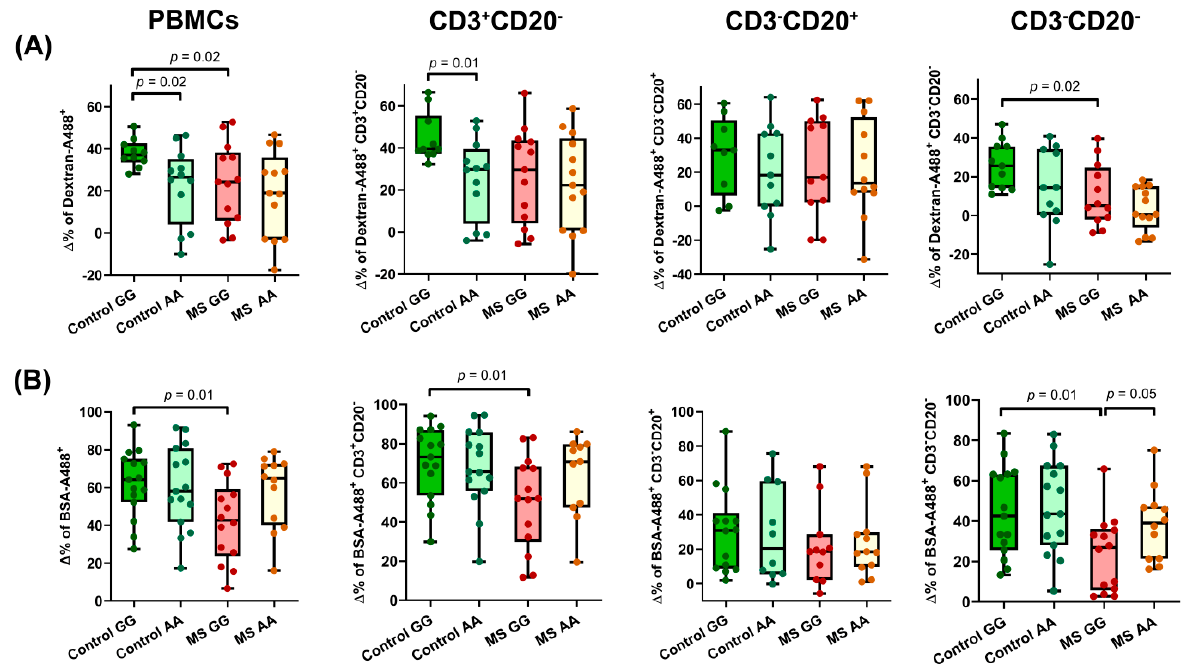
Figure 2. Effect of rs7665090 genotypes on endocytosisin PBMCs from healthy donors and MS patients pre-stimulated for 24 h or not with PHA. ( A ) Endocytosis of A488-Dextran 10 KDa at 0.5 mg/mL for 15 min by overall PBMCs, T cells (CD3 + CD20 − ), B cells (CD3 − CD20 + ) and other lymphocytes (CD3 − CD20 − ) was assessed (controls GG n = 10; controls AA n = 12; MS GG n = 13; MS AA n = 13). PBMCs: percentage of difference between means in Control GG vs. Control AA = 24.94 ± 20.29%; Control GG vs. MS GG = 29.66 ± 22.75%; Percentage of difference between means in CD3 + CD20 − : Control GG vs. Control AA = 43.51 ± 15.54%; Percentage of difference between means in CD3 − CD20 + : Control GG vs. MS GG = 59.58 ± 23.05%. ( B ) Endocytosis of A488-BSA at 25 µ g/mL for 4 h in the same cellular subsets (controls GG n = 15; controls AA n = 15; MS GG n = 14; MS AA n = 12). PBMCs: percentage of difference between means in Control GG vs. MS GG = 32.33 ± 11.69%; CD3 + CD20 − : percentage of difference between means in Control GG vs. MS GG = 28.5 ± 11.3%; Percentage of difference between means in CD3 − CD20 − : Control GG vs. MS GG = 46.97 ± 17.15%; MS GG vs. MS AA = 38.33 ± 18.73%. Box and whiskers diagrams: the line represents the median value, the box the 25 and 75 percentiles and whiskers mark maximum and minimum values. All comparisons were performed with Student’s t